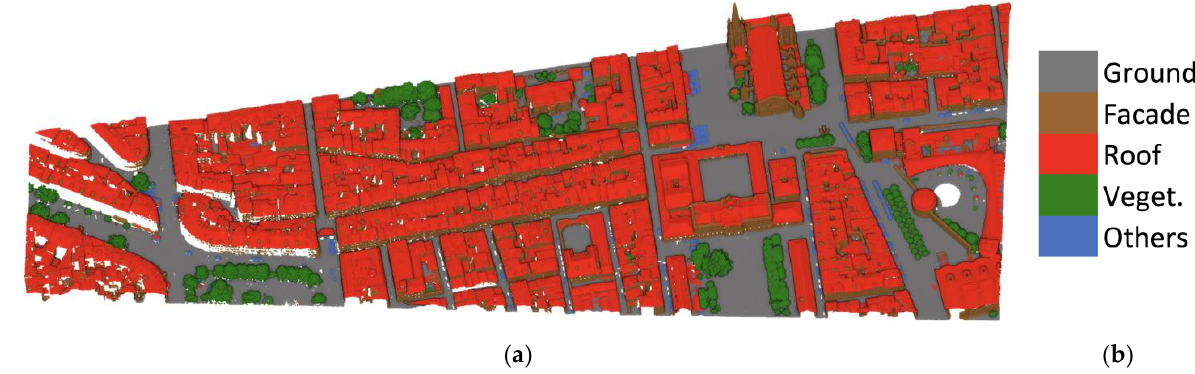
Figure 16. ( a ) Classification result on the testing area of the Bordeaux dataset with our 2DCNN, ( b ) legend.